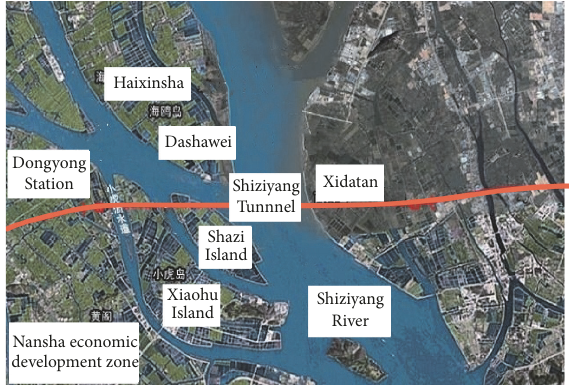
Figure 3: The planar graph of the Shiziyang subsea